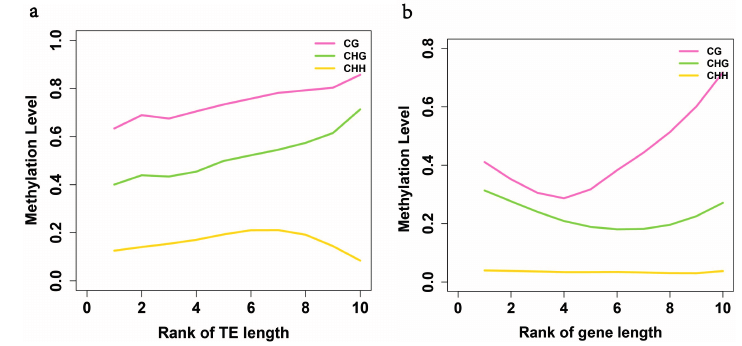
Figure 4. Analysis of the relationships between methylation level and sequence length.